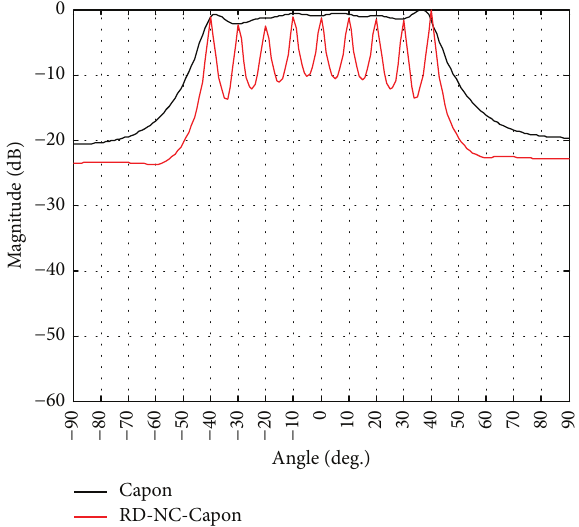
Figure 5: The spectrum search results of RD-NC-Capon algorithm (SNR = 20 dB, 𝑀 = 8 , 𝐿 = 200 , and 𝐾 = 9 ).